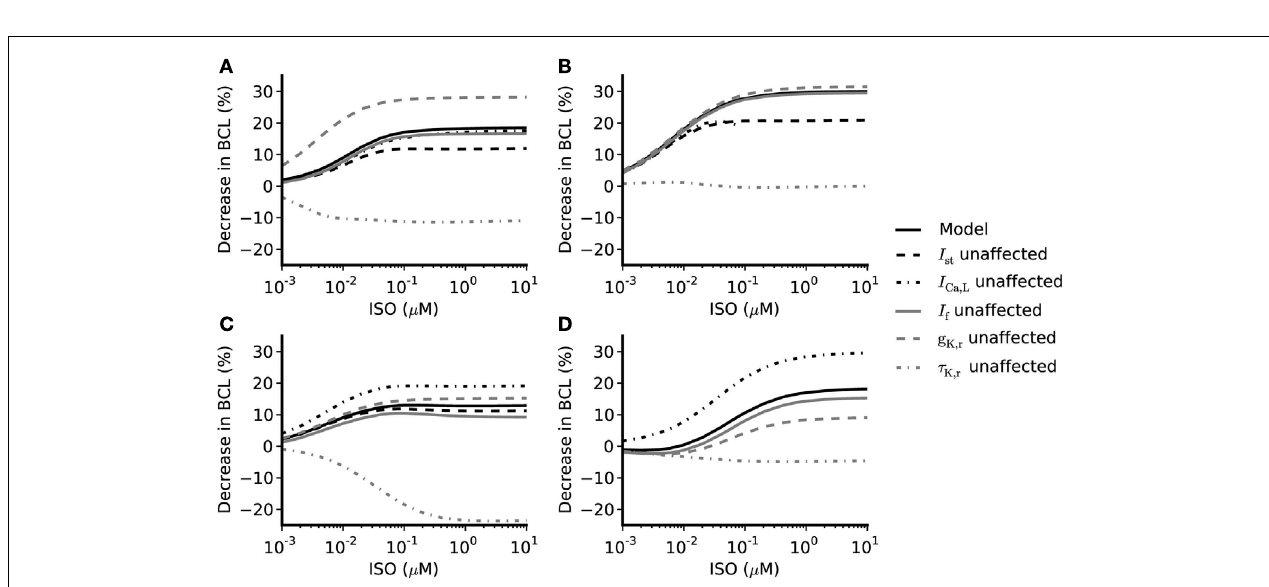
FIGURE 4 | Concentration-dependent percentage decrease of pacemaking cycle length (BCL) by ISO. (A,B) Boyett et al. and Kurata et al. central cell models. (C,D) Boyett et al. and Kurata et al. peripheral cell models. The figure incorporates concentration-response data from the models and relevant experimental data. Black line: data from the standard configuration of